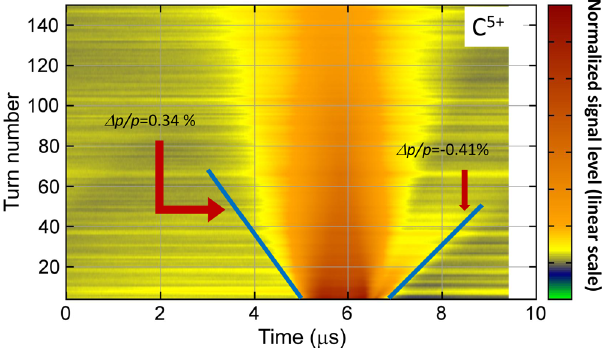
FIG. 6. Time-turn plane view of the free run of C 5 þ where a low-energy component in the tail is visible (color changed to make the image clear).